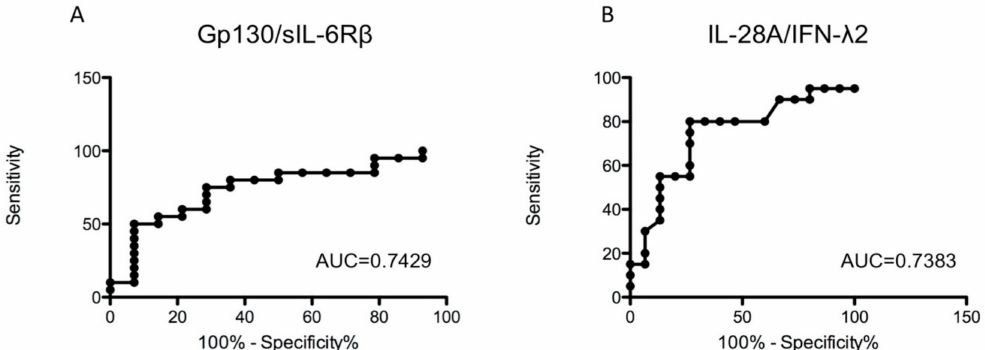
Figure 3. Areas under the curves obtained with the sensitivity and specificity for the serum levels of glycoprotein-130 (gp130 / sIL-6Rb) ( A ) and IL-28A / IFN-l2 ( B ) in Musc-LMNA. True positive rate (sensitivity (SE)) on the y-axis is represented as function of the false positive rate (100%—specificity% (SP)) on the x-axis. Higher y values correspond to a higher SE, whereas lower x values correspond to a higher